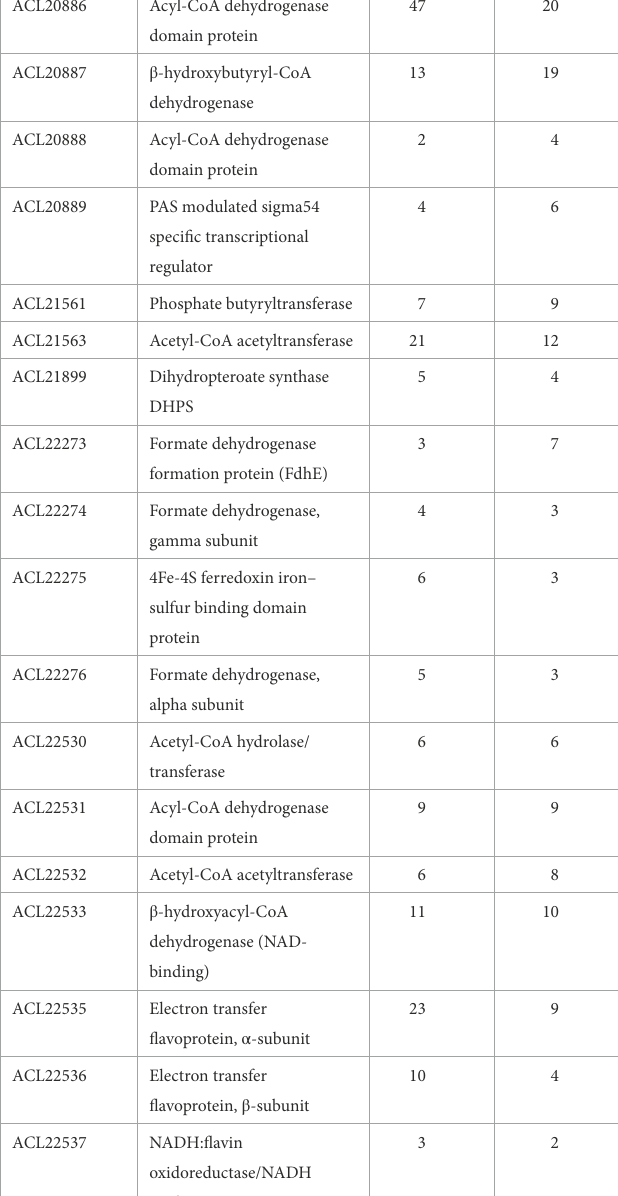
TABLE 2 Selected proteins and operons significantly up-regulated with H 2 as electron donor and acetate as carbon source. Accession Predicted